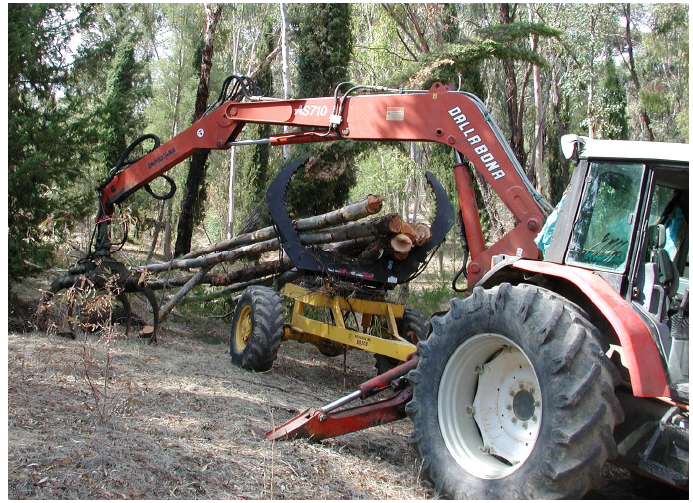
Figure 5. Clambunk skidder attachment for farm-tractor based skidders.